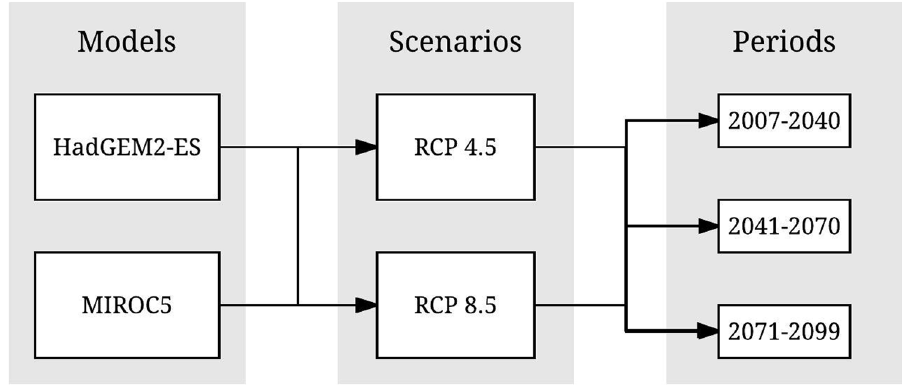
Figure 4. Climate change scenarios used in the present